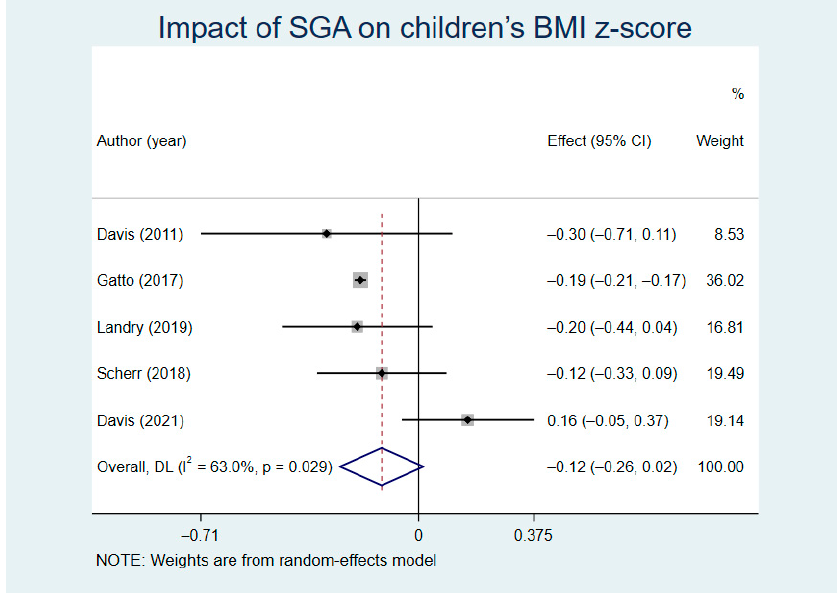
Figure 6. Impact of SGA on children’s body mass index z ‐ score (BMI z ‐ score).